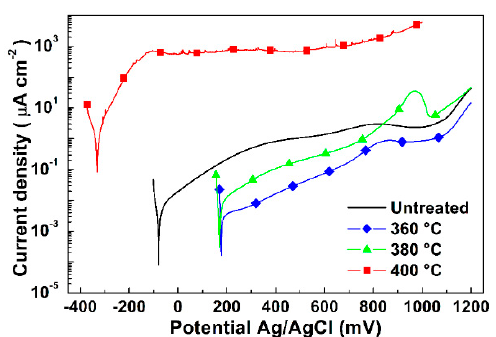
Figure 11. Polarization curves of samples untreated, nitrided for 3 h, at 360 and 380 °C, using 50 vol.% N 2 + 50 vol.% H 2 , and at 400 °C, using 80 vol.% N 2 + 20 vol.% H 2